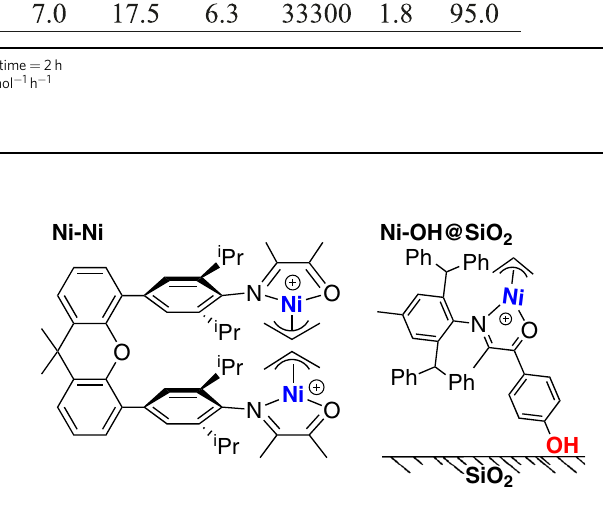
Fig. 4 Chemical structures of the dinuclear and supported nickel complexes. A dinuclear nickel complex ( Ni – Ni ) was prepared from a xanthene-bridged di-amine. A SiO 2 supported nickel complex ( Ni – OH@SiO 2 ) was generated from the interaction of a pre-installed anchoring group (OH) with the solid